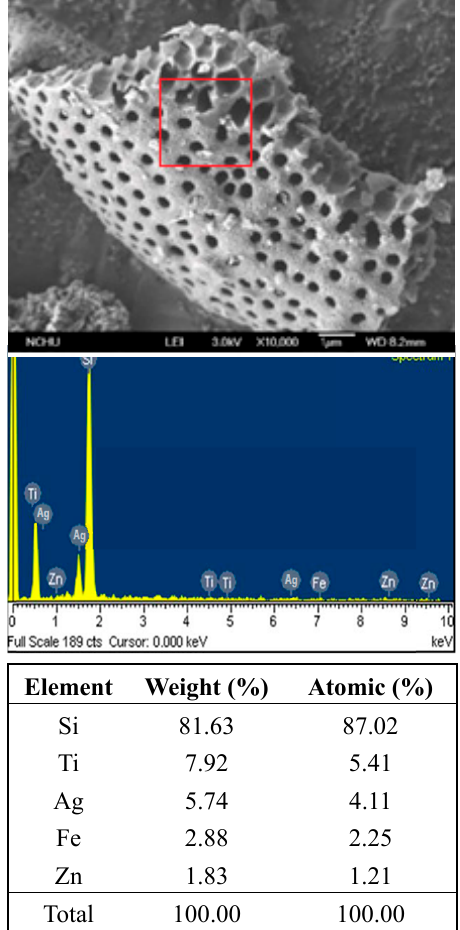
Figure 1. SEM images of Ag-TiO 2 film on diatomite and EDAX analysis of Ag-TiO 2 /DM composite film.